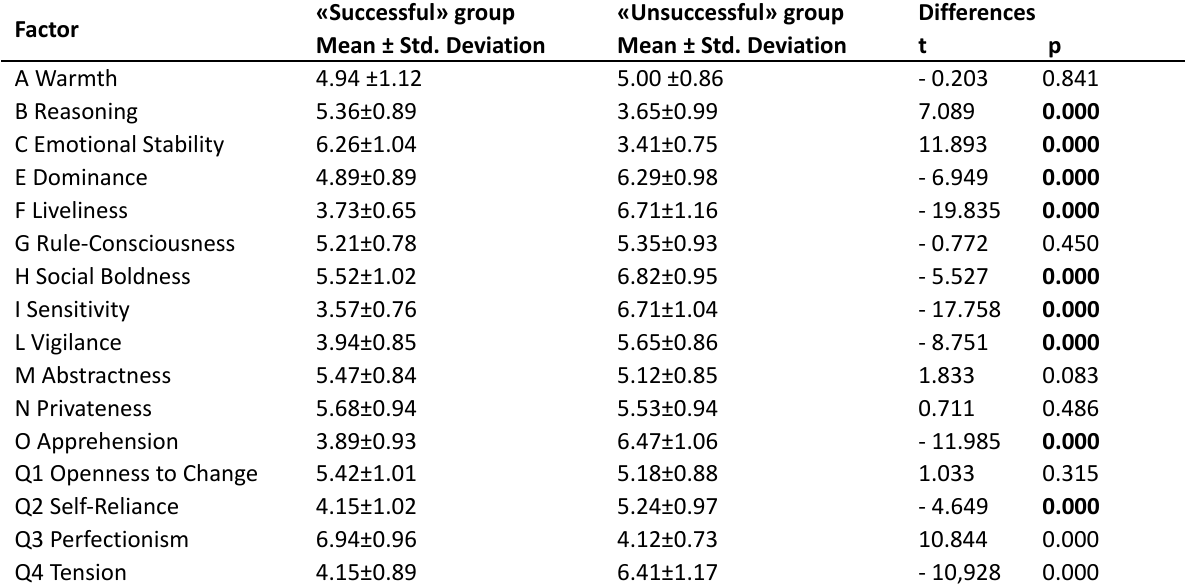
Table 1. Statistically significant differences in the level of development of personal qualities in a group of successful and unsuccessful